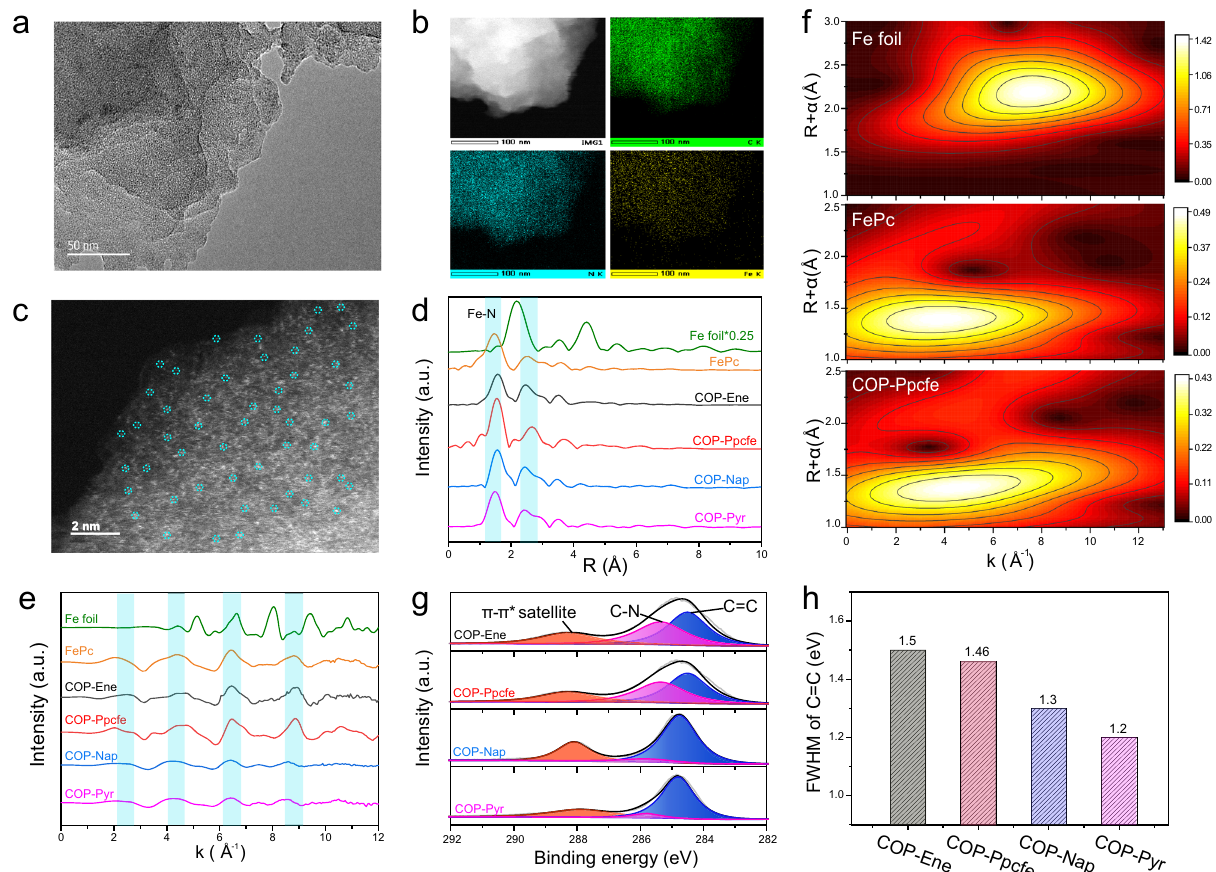
Fig. 2 Morphology and structure characterization. a The HRTEM images of COP-Ppcfe sample. b STEM image and the corresponding EELS elemental mapping of C (green), N (blue), and Fe (yellow) in COP-Ppcfe sample. c The HAADF STEM images of COP-Ppcfe sample. d The Fourier transforms of the EXAFS spectra for four samples, Fe foil, and FePc. e The corresponding EXAFS k space fi tting curves of four samples, Fe foil, and FePc. f The Wavelet transform of COP-Ppcfe sample. g The C1 s XPS spectra of the four as-synthesized COP samples. h The full-width at half maxima value (FWHM) of C = C bond in C 1 s of the four as-synthesized COP